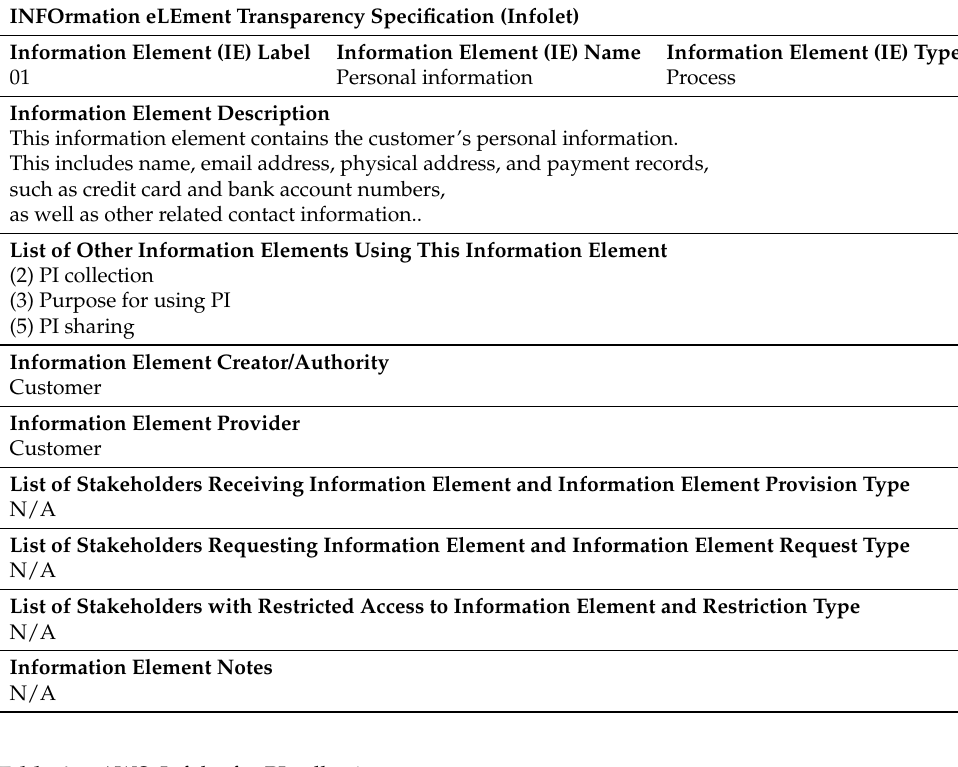
Table A3. AWS: Infolet for PI